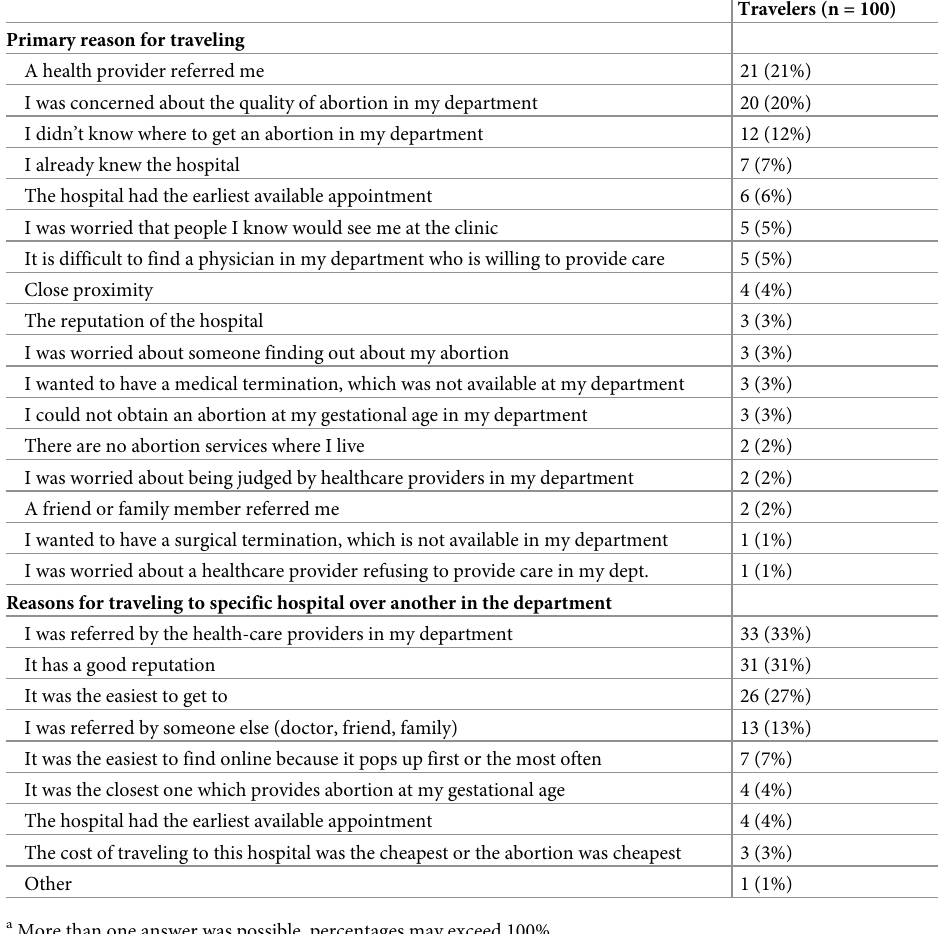
Table 4. Reasons for traveling for abortion